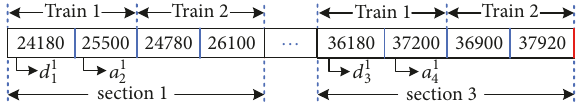
Figure 4: A particle for the sample